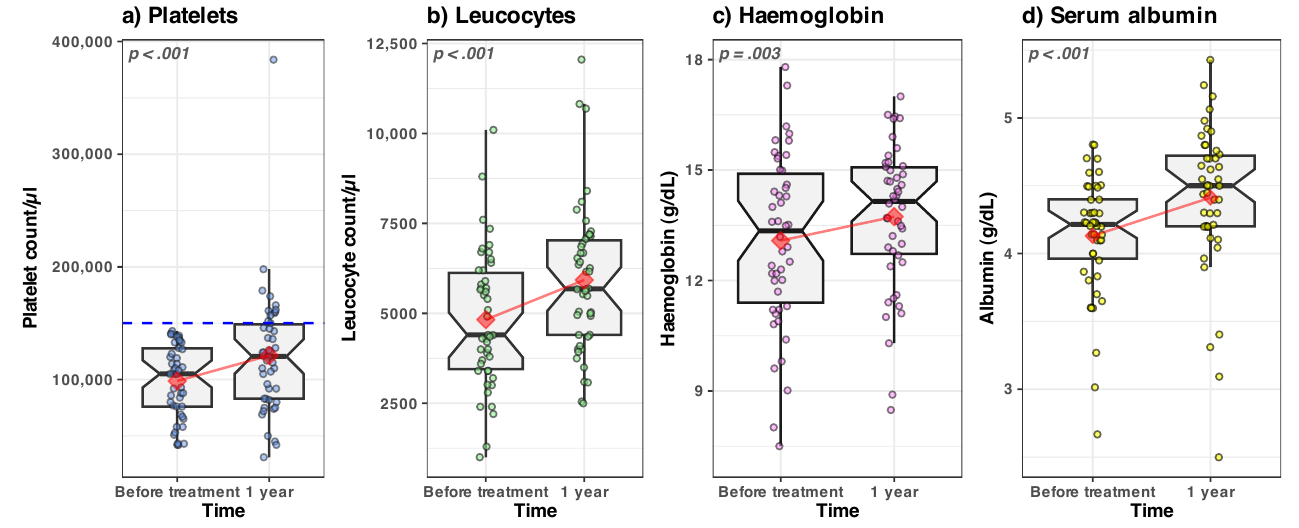
Figure 2. Boxplots of the serum markers evolution in time. The values recorded from each patient are represented by the dots (slightly jittered for clarity). The median value is represented by the horizontal thick black line. The lower and upper hinges correspond to the first and third quartiles (the interquartile range). The whiskers extend to 1.5 times the interquartile range; data points outside the whiskers are potential outlier values. The notches extend to the 95% confidence intervals for comparing the medians. The mean value of each subgroup is represented by the red diamond; the connecting red lines are meant as a guide to the eye to spot the trend. The dashed line in panel ( a ) represents the threshold value of 150,000